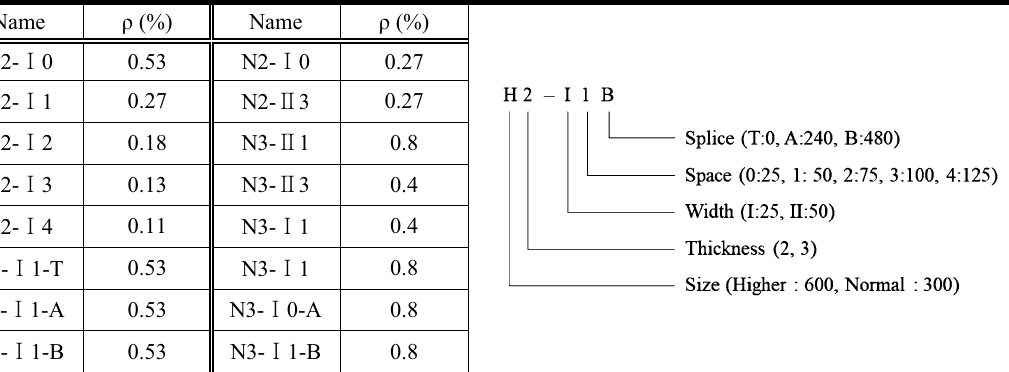
Table 4 Summary of retrofitting specimen property.